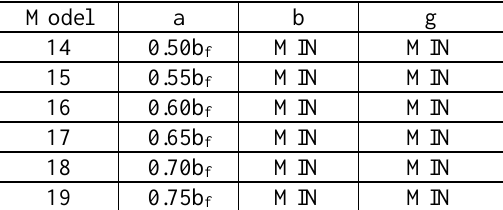
RBS flange cut dimensions with variable “a”